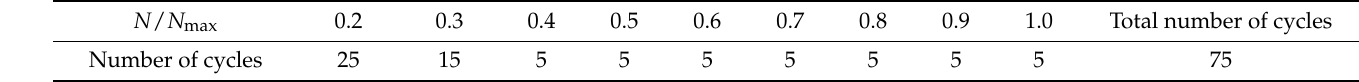
Table 2. Loading amplitudes for dynamic